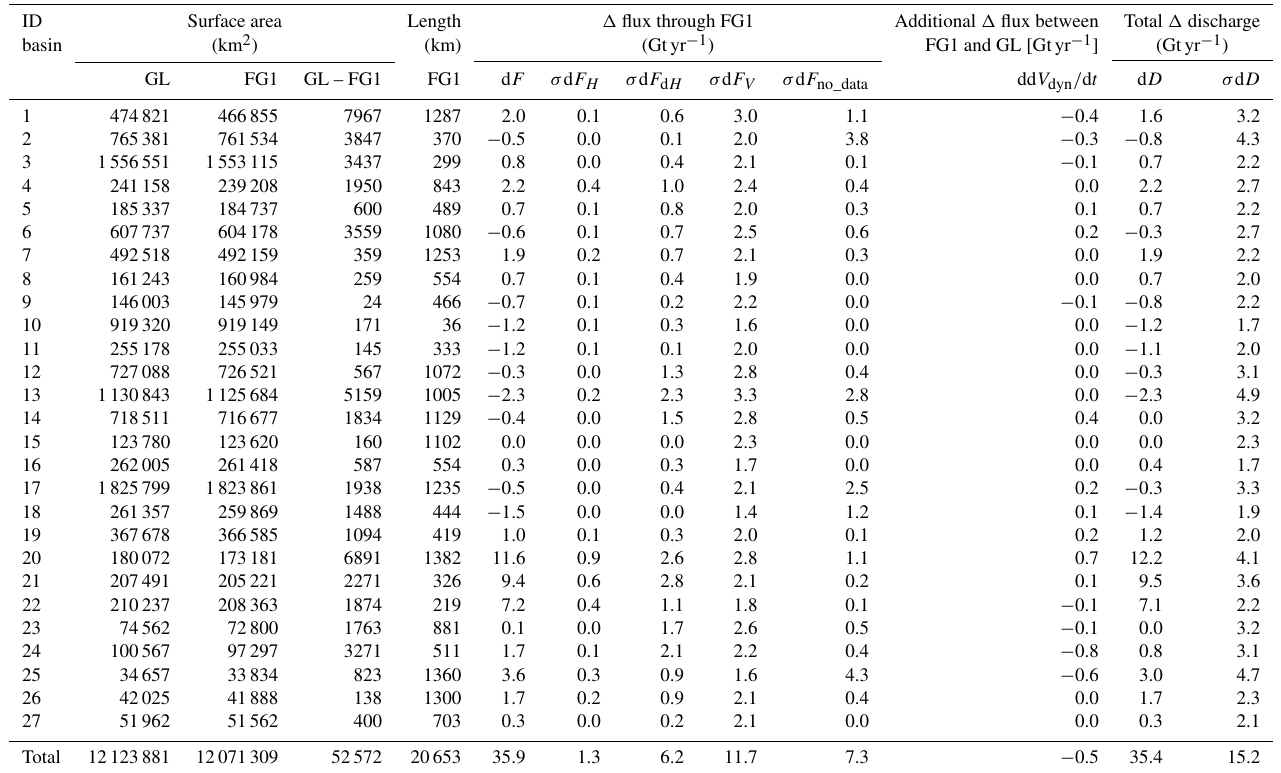
Table A4. Detailed breakdown of the change in discharge ( (cid:49)D) estimate presented in Table 2 using JPL auto-RIFT 2015 weighted average velocity (W15), ∼ 2008 velocities from Rignot et al. (2011a), the FG1 flux gate and GL0 grounding line. d F is change in flux across the grounding line and dd V dyn / d t is the change in dynamic volume change for the area between FG1 and GL0. All error terms and their propagation are describe in Sect.